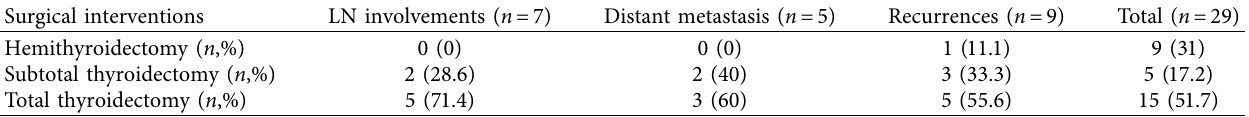
Table 4: Surgical interventions with the outcome of PTC.